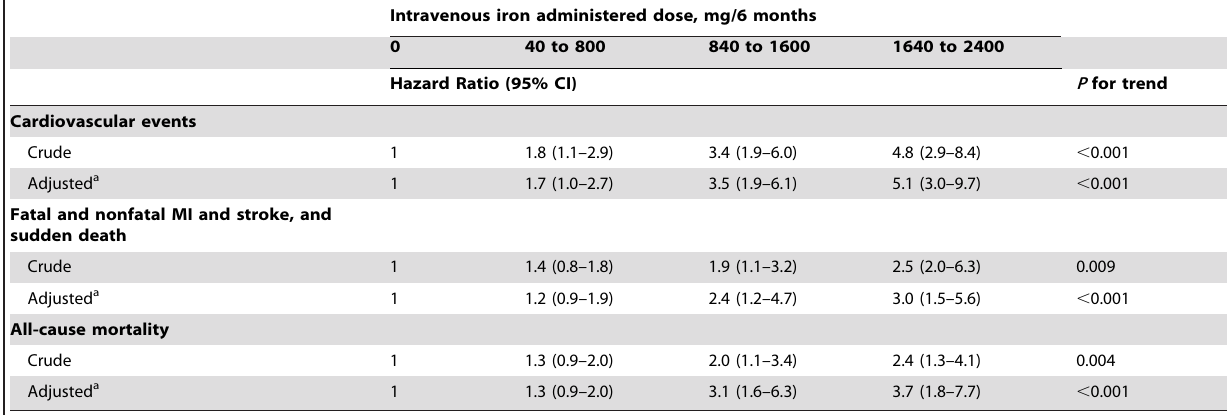
Table 2. Multivariate Cox proportional hazards analysis for relative risk of cardiovascular events and overall mortality calculated for intravenous iron groups in a follow-up of 12